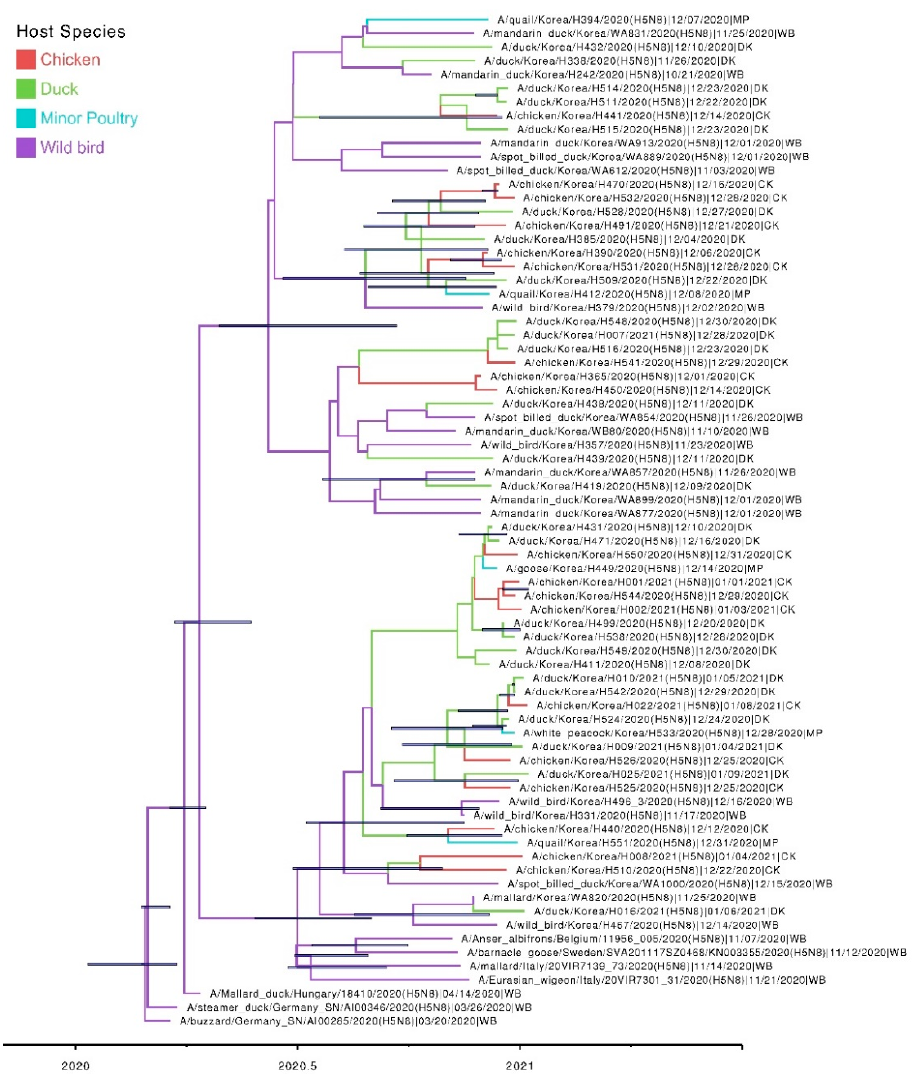
Figure 4. Host transition and MCC tree for HA gene (clusters G1 and G2) of H5N8 highly pathogenic avian influenza virus for 2020–2021 outbreak in South Korea. Coding region of hemagglutinin was used for the reconstruction of the phylogenetic tree. Branches are colored according to host type. Horizontal bars on the nodes indicate the 95% Bayesian credibility intervals of divergence time estimates. Scale bar indicates the branch lengths in a year.